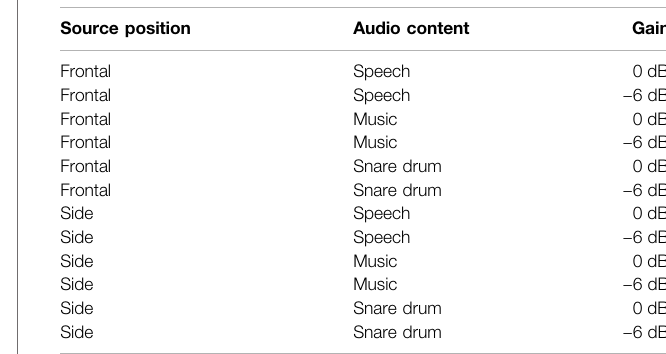
TABLE 2| Twodifferent source positions, three types ofsignals,and two different sound levels were taken into